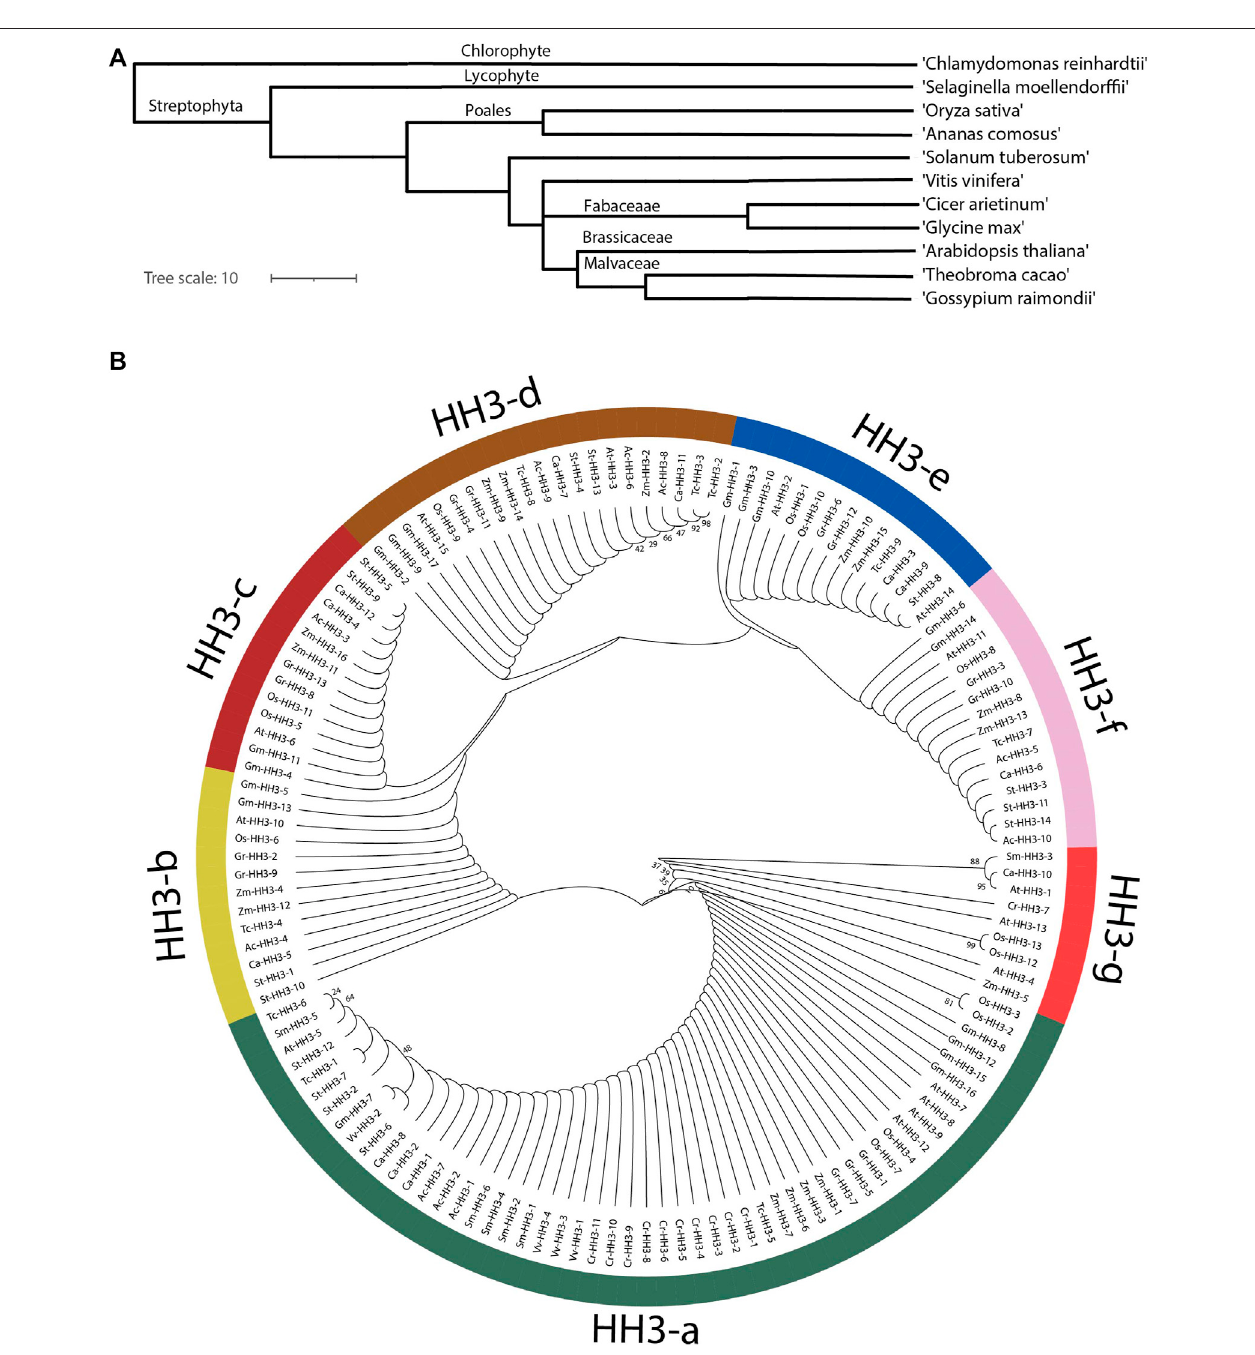
FIGURE 1 | Phylogenetic analyses of the HH3 gene in different organisms. (A) Phylostratum analysis of HH3 genes. (B) Phylogenetic tree divided members of HH3 genes in seven clades; green color shows clade-a, yellow colors shows clade-b, maroon color shows clade-c, brown color shows clade-d, and blue color shows